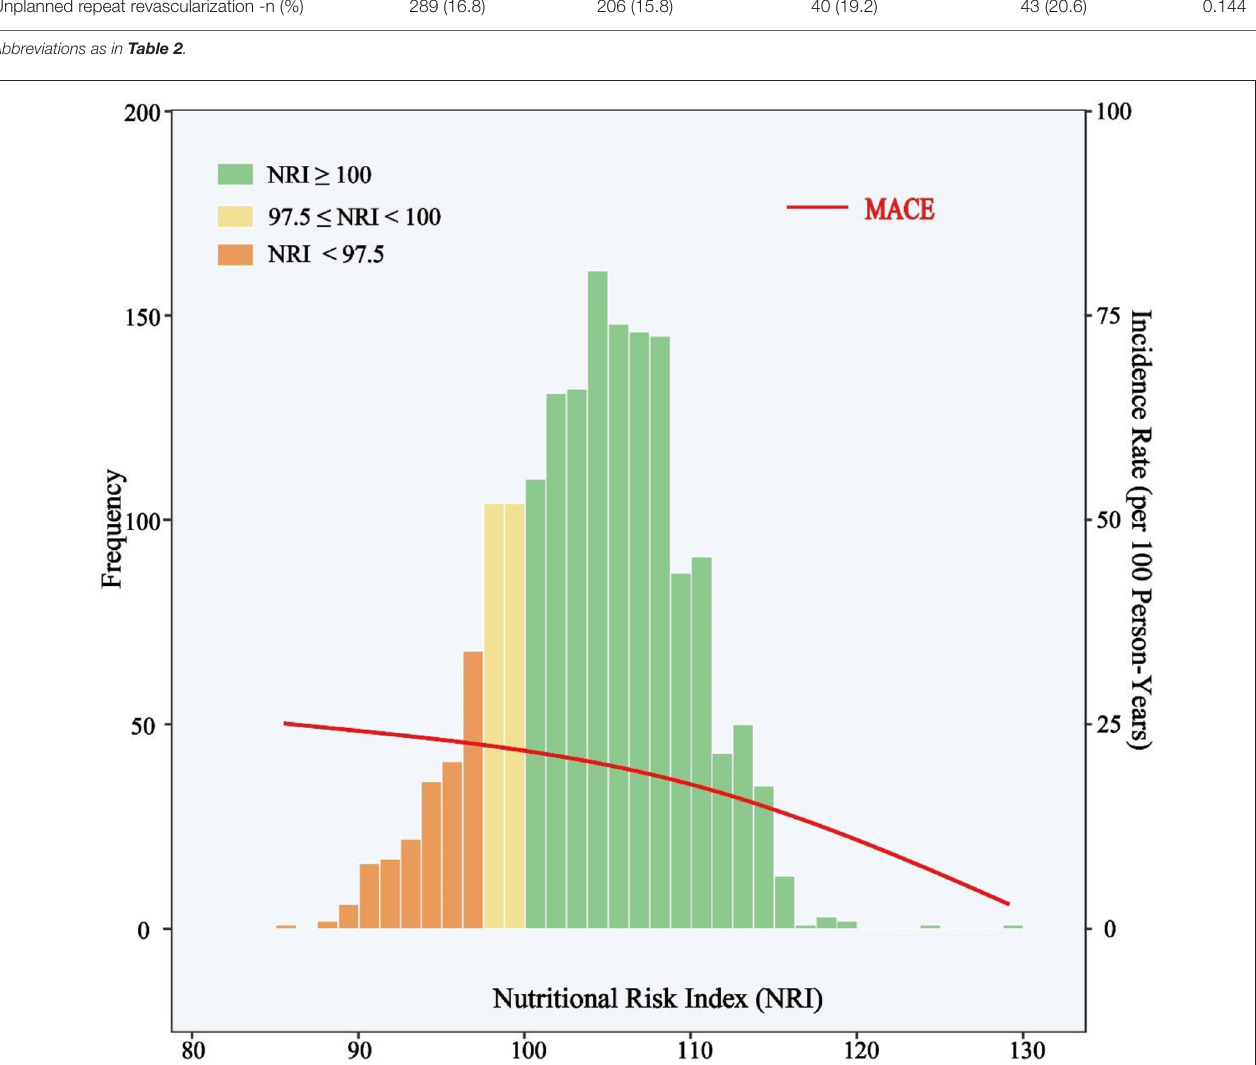
FIGURE 2 | Distribution of NRI and Incidence Rate of MACE. The incidence rate curve of MACE is shown in the red line. Histograms show the population distribution of NRI. The left y-axis shows the frequency of subjects in each NRI intervals and the right y-axis shows the incidence rate (events per 100 person-years) of MACE. The x-axis shows the score of NRI by 1.5 intervals. MACE include all-cause death, non-fatal stroke, non-fatal myocardial infarction, or unplanned repeat revascularization. NRI, nutritional risk index; MACE, major adverse cardiovascular events.